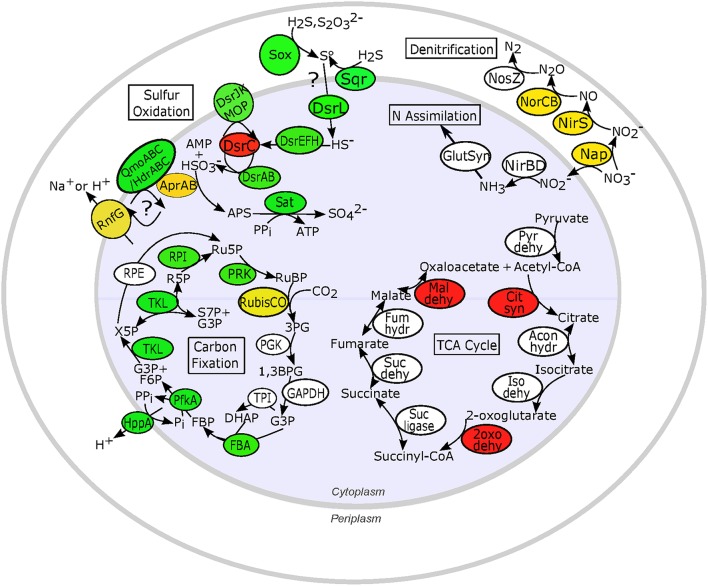
Expression patterns for key proteins involved in proposed sulfur oxidation, nitrogen reduction and assimilation, and carbon metabolism pathways in chemosynthetic Ifremeria nautilei symbionts. Proteins and complexes are colored based on transcript abundance in snail metatranscriptomes: green, constitutive expression (transcripts detected in all metatranscriptomes); yellow, HD expression > LD expression (FDR < 0.05); red, LD expression > HD expression (FDR < 0.05); white, sporadic or low expression (transcripts detected in fewer than 9 of the 12 metatranscriptomes); only proteins for which transcripts were detected are shown. Sulfur oxidation: Sox, Sox multi enzyme complex; AprAB, adenylylsulfate reductase; DsrL, Sulfur oxidation-associated protein DsrL; DsrEFH, putative sulfurtransferase complex; DsrC, putative bacterial heterodisulfide; DsrAB, reverse-type dissimilatory sulfite reductase; DsrJKMOP, sulfite reduction-associated complex DsrMKJOP; QmoABC/HdrABC, putative quinone-interacting membrane-bound oxidoreductase; RnfG, Rnf electron transport complex; Sat, sulfur adenylyltransferase; Sqr, sulfide quinone (oxido)reductase. N metabolism: Nap, periplasmic nitrate reductase; NirS, membrane-bound respiratory nitrite reductase; NirBD, NADH-dependent siroheme nitrite reductase; NorCB, nitric oxide reductase; NosZ, nitrous oxide reductase; GlutSyn, glutamine synthetase + glutamate synthase. TCA cycle: Pyr dehy, pyruvate dehydrogenase; Cit syn, citrate synthase; Acon hydr, Aconitate hydratase; Iso dehy, Isocitrate dehydrogenase; 2oxo dehy, 2-oxoglutarate dehydrogenase; Suc ligase, Succinyl-CoA ligase; Suc dehy, Succinate dehydrogenase; Fum hydr, Fumarate hydratase class I; Mal dehy, Malate dehydrogenase. Carbon fixation: RubisCO, Ribulose bisphosphate carboxylase; PGK, Phosphoglycerate kinase; GAPDH, NAD-dependent glyceraldehyde-3-phosphate dehydrogenase; TPI, Triosephosphate isomerase; FBA, Fructose bisphosphate aldolase; PfkA, Reversible pyrophosphate-dependent phosphofructokinase; HppA, membrane-bound proton-translocating pyrophosphatase; TKL, Transketolase; RPE, Ribulose-phosphate-3-epimerase; RPI, Ribose-5-phosphate isomerase A; PRK, Phosphoribulokinase; RuBP, Ribose-1,5-bisphosphate; 3PG, 3-phosphoglycerate; G3P, Glyceraldehyde-3-phosphate; DHAP, Dihydroxyacetone phosphate; FBP, Fructose-1,6-bisphosphate; F6P, Fructose-6-phosphate; X5P, Xylose-5-phosphate; Ru5P, Ribulose-5-phosphate; R5P, Ribose-5-phosphate; S7P, Sedoheptulose-7-phosphate; PPi, inorganic pyrophosphate; Pi, inorganic phosphate.